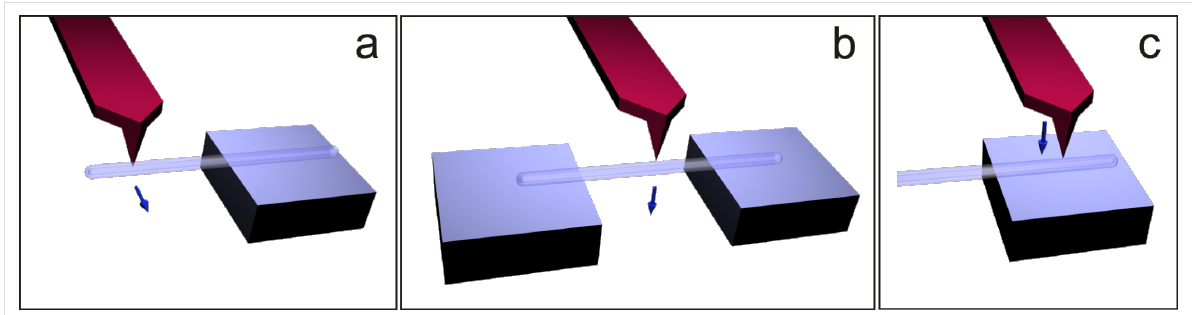
Figure 1: Schematics of mechanical tests performed on SiO 2 NTs. Cantilever (half-suspended) beam bending inside SEM by using a nanomanipu- lator equipped with a QTF force sensor (a). Three-point beam bending (b) and nanoindentation (c) by using ambient AFM. The arrows indicate the direction of force